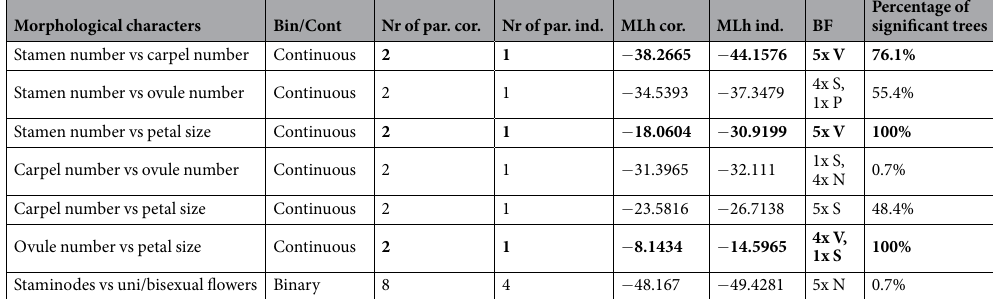
Strong to very strong correlations were found between number of stamen, petal size and the number of ovules per carpel, indicating that the simplification of flowers has occurred jointly for different parts of the flowers. The number of carpels is only strongly correlated with the number of stamens when considering Bayes factors, and less strong after the likelihood ratio test (in only 76% of the input trees). The correlation between petal size and number of carpels was strong considering Bayes factors and weak between number of ovules and number of carpels, while the likelihood ratio tests found no significant correlations between these variables in the majority of input trees. The discrete tests of correlation did not retrieve evidence for a correlation between presence of staminodes and flower sexuality (Table 1). The tests for mode of evolution significantly favoured a pulsed mode for the number of stamens and the num- ber of carpels, indicated by kappa estimates of 0.01 and 0.1 respectively. No evidence for a significant deviation from a gradual mode of evolution was found for the number of ovules per carpel, while evidence for a deviation from a gradual mode of evolution was found using likelihood ratio tests for the petal length. The kappa estimate for petal length of 1.9 indicates that long branches contribute more to the evolution of petal length than would be expected under a gradual mode of evolution. However the Bayes factors did not indicate a deviation from a gradual mode of evolution for the petal length, suggesting that the signal is very weak if present (Table 2).